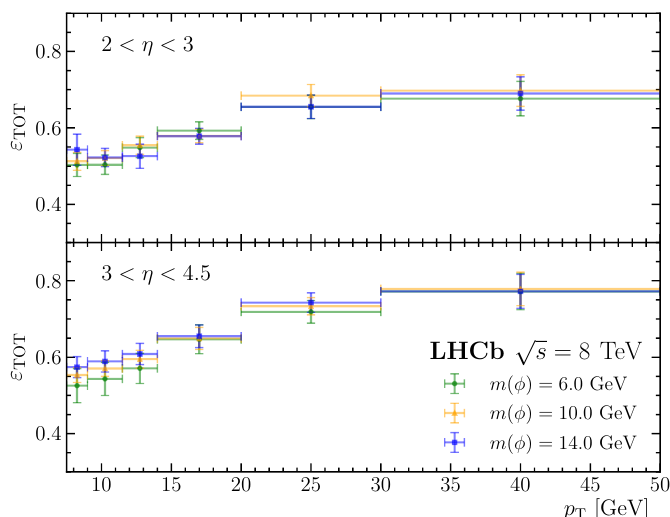
Figure 2 . Total e(cid:14)ciency as a function of the p T of the dimuon candidate for the two (cid:17) ( (cid:30) ) bins considered, obtained for three di(cid:11)erent (cid:30) boson mass hypotheses. (cid:12)gure 1. The small di(cid:11)erences (1{5%) in the e(cid:14)ciencies found are assigned as systematic